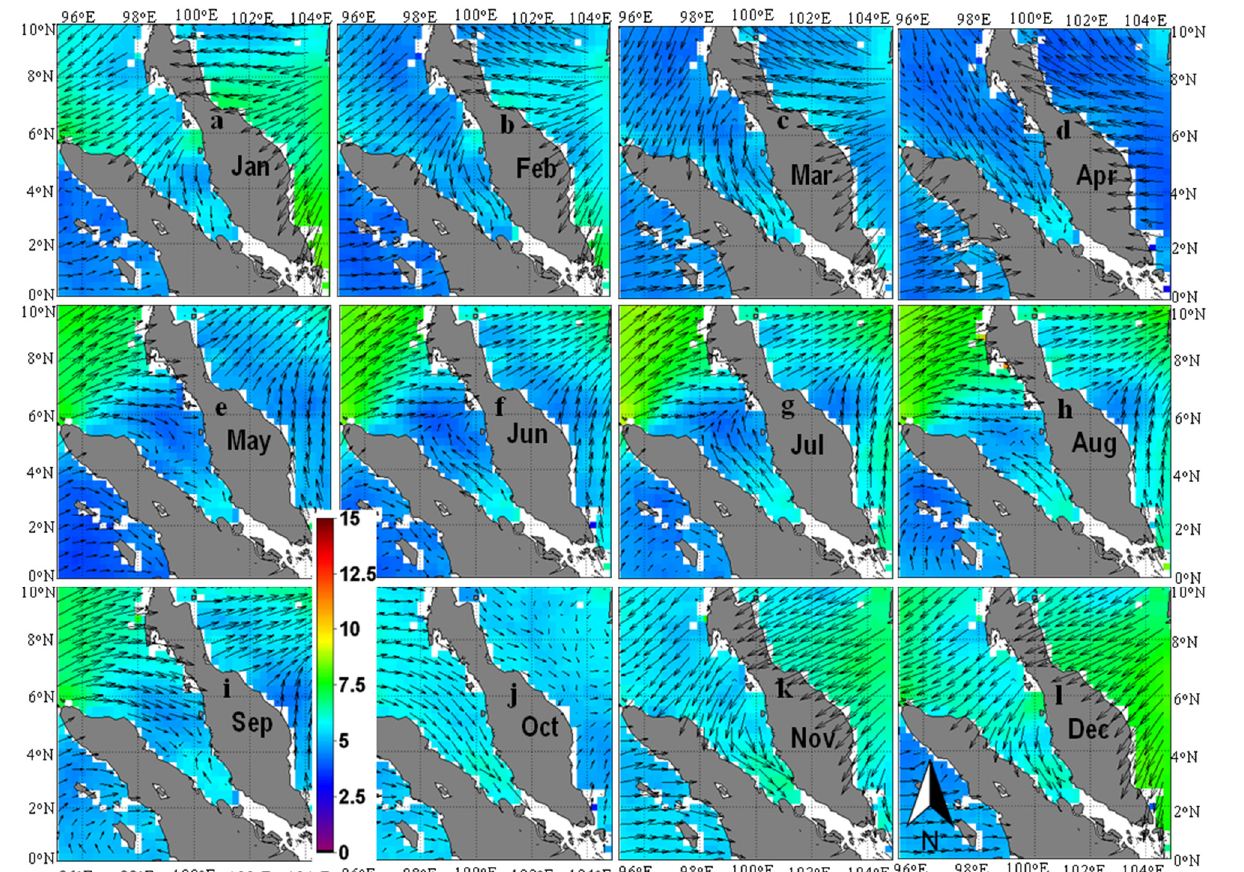
Figure 11. ( a – l ) Monthly climatological means of wind speed (m∙s −1 ) and wind vector averaged from monthly QuikScat wind field data retrieved within the period of the SeaWiFS